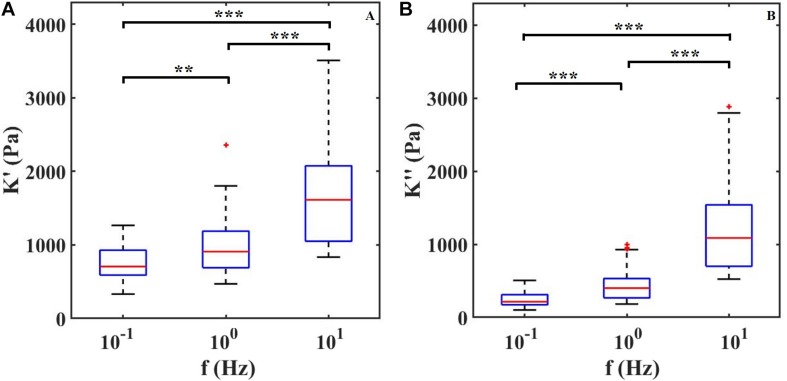
(A) Apparent storage (K′) and (B) loss (K″) moduli plotted as a function of indentation frequency. Each column contains data of two retinae and around 30 measurements per frequency. ∗∗P < 0.01 and ∗∗∗P < 0.0005 by Kruskal–Wallis test.